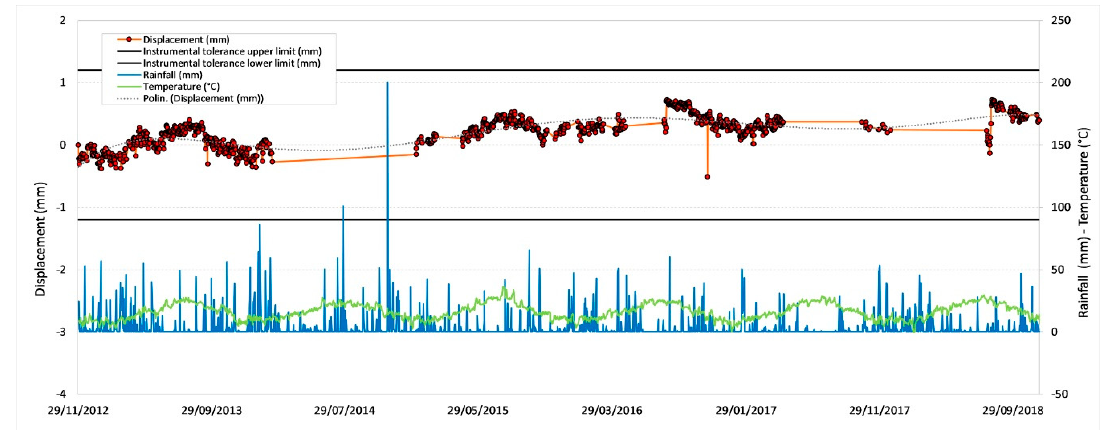
Figure 14. Displacement recorded by the RTS at the measurement point P07.